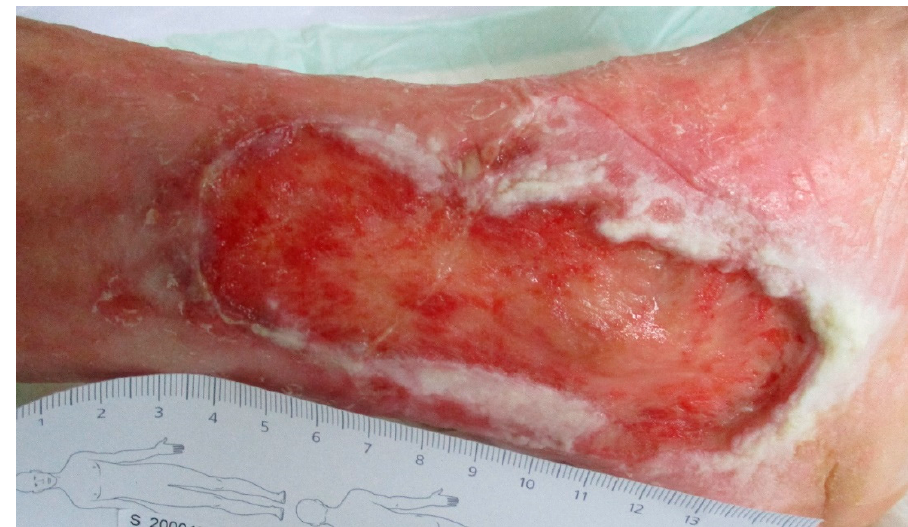
Figure 3. Ulcer post-larvae application (2 pictures of the same wound).